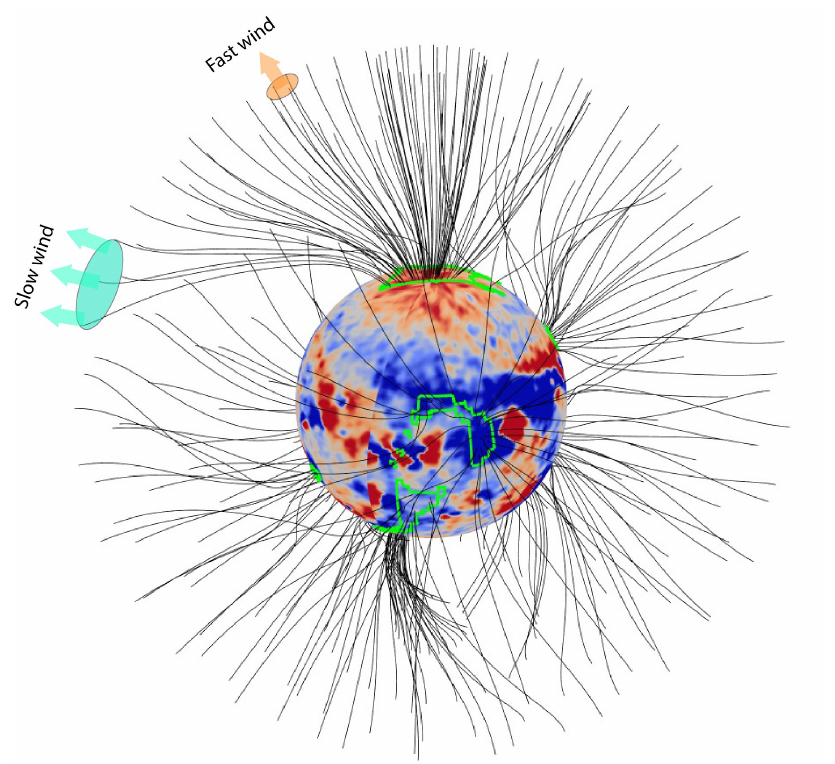
Figure 1. Demonstration of the WSA model: fast and slow flows. Calculations in the PFSS approxi- mation from the STOP (Kislovodsk Mountain Astronomical Station) observations, 2259 Carrington rotations. The green contours indicate the boundaries of